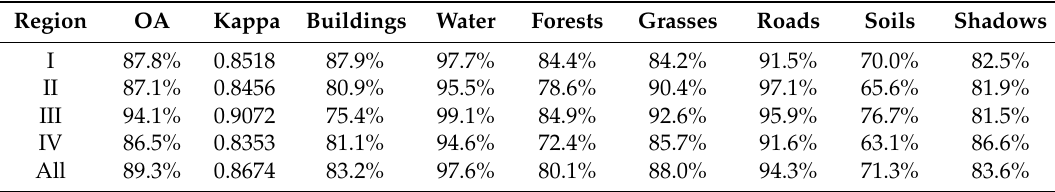
Figure 8. Classification maps of the four test regions provided by the object-based approach (yellow = buildings, blue = water, dark green = forests, light green = grasses, pink = roads, orange = soils, and black = shadows). Table 6. Classification accuracies of the object-based approach in the four test regions in terms of overall accuracy, Kappa coefficient, and F1-score for each class.